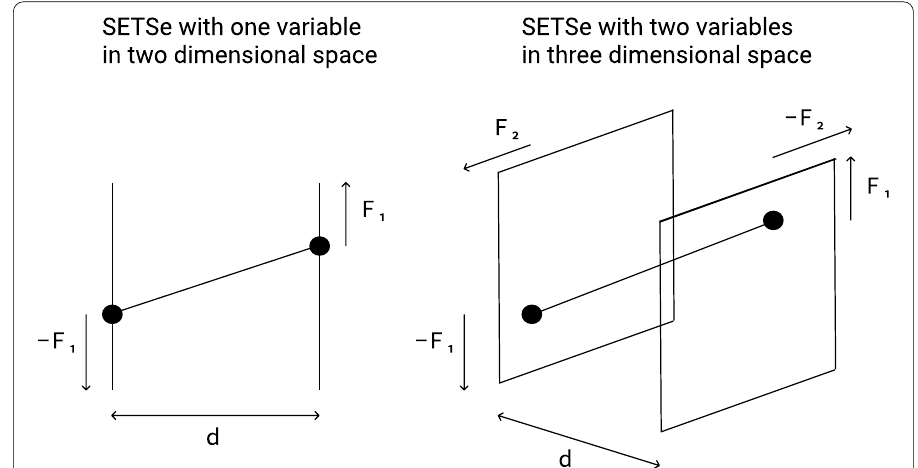
Fig. 2 Two nodes in a network in two-dimensional and three-dimensional SETSe systems. The minimum distance d between the nodes is maintained by the graph space